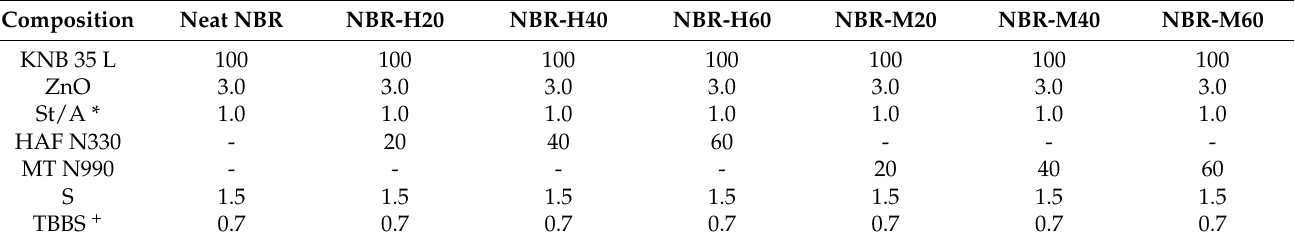
Table 1. Compositions of the NBR with HAF and MT CB